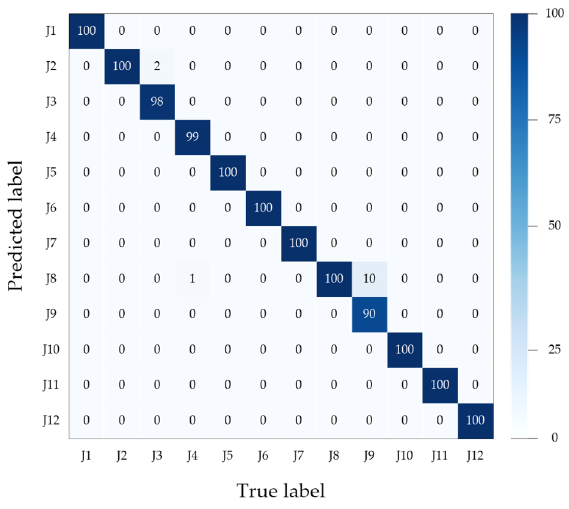
Figure 11. JR-TFViT_S confusion matrix at JNR = − 6 dB.